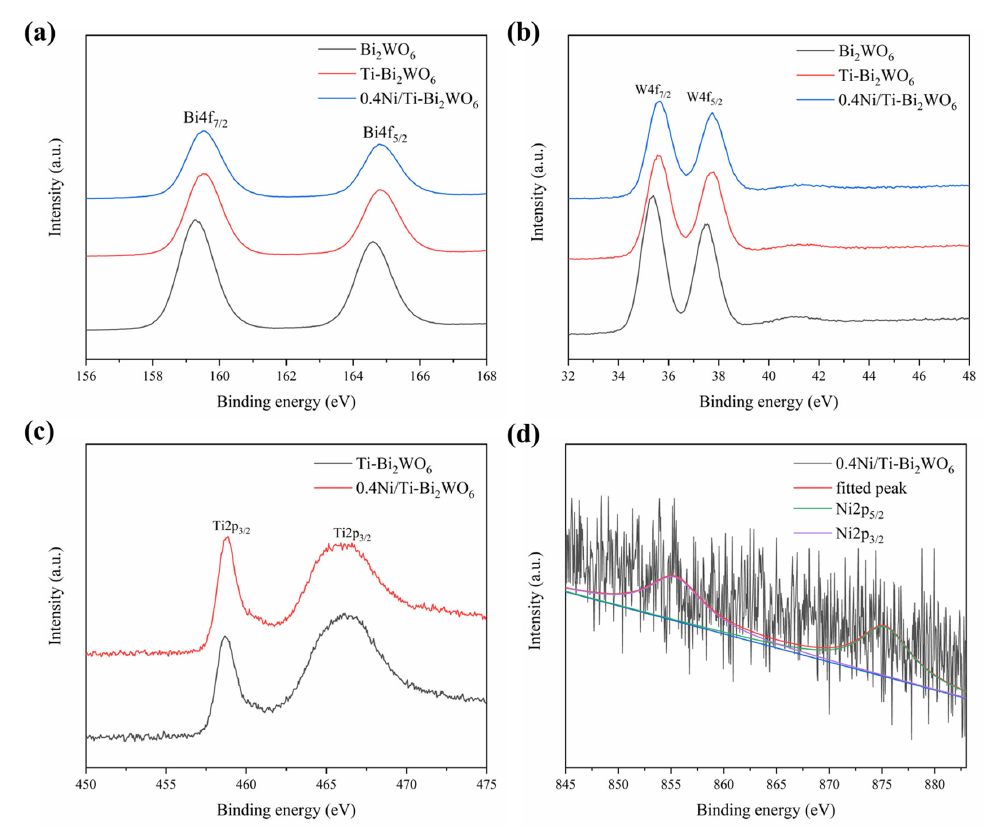
Figure 6. The XPS spectra of various samples: ( a ) Bi4f, ( b ) W4f, ( c ) Ti 2p, and ( d ) Ni 2p.